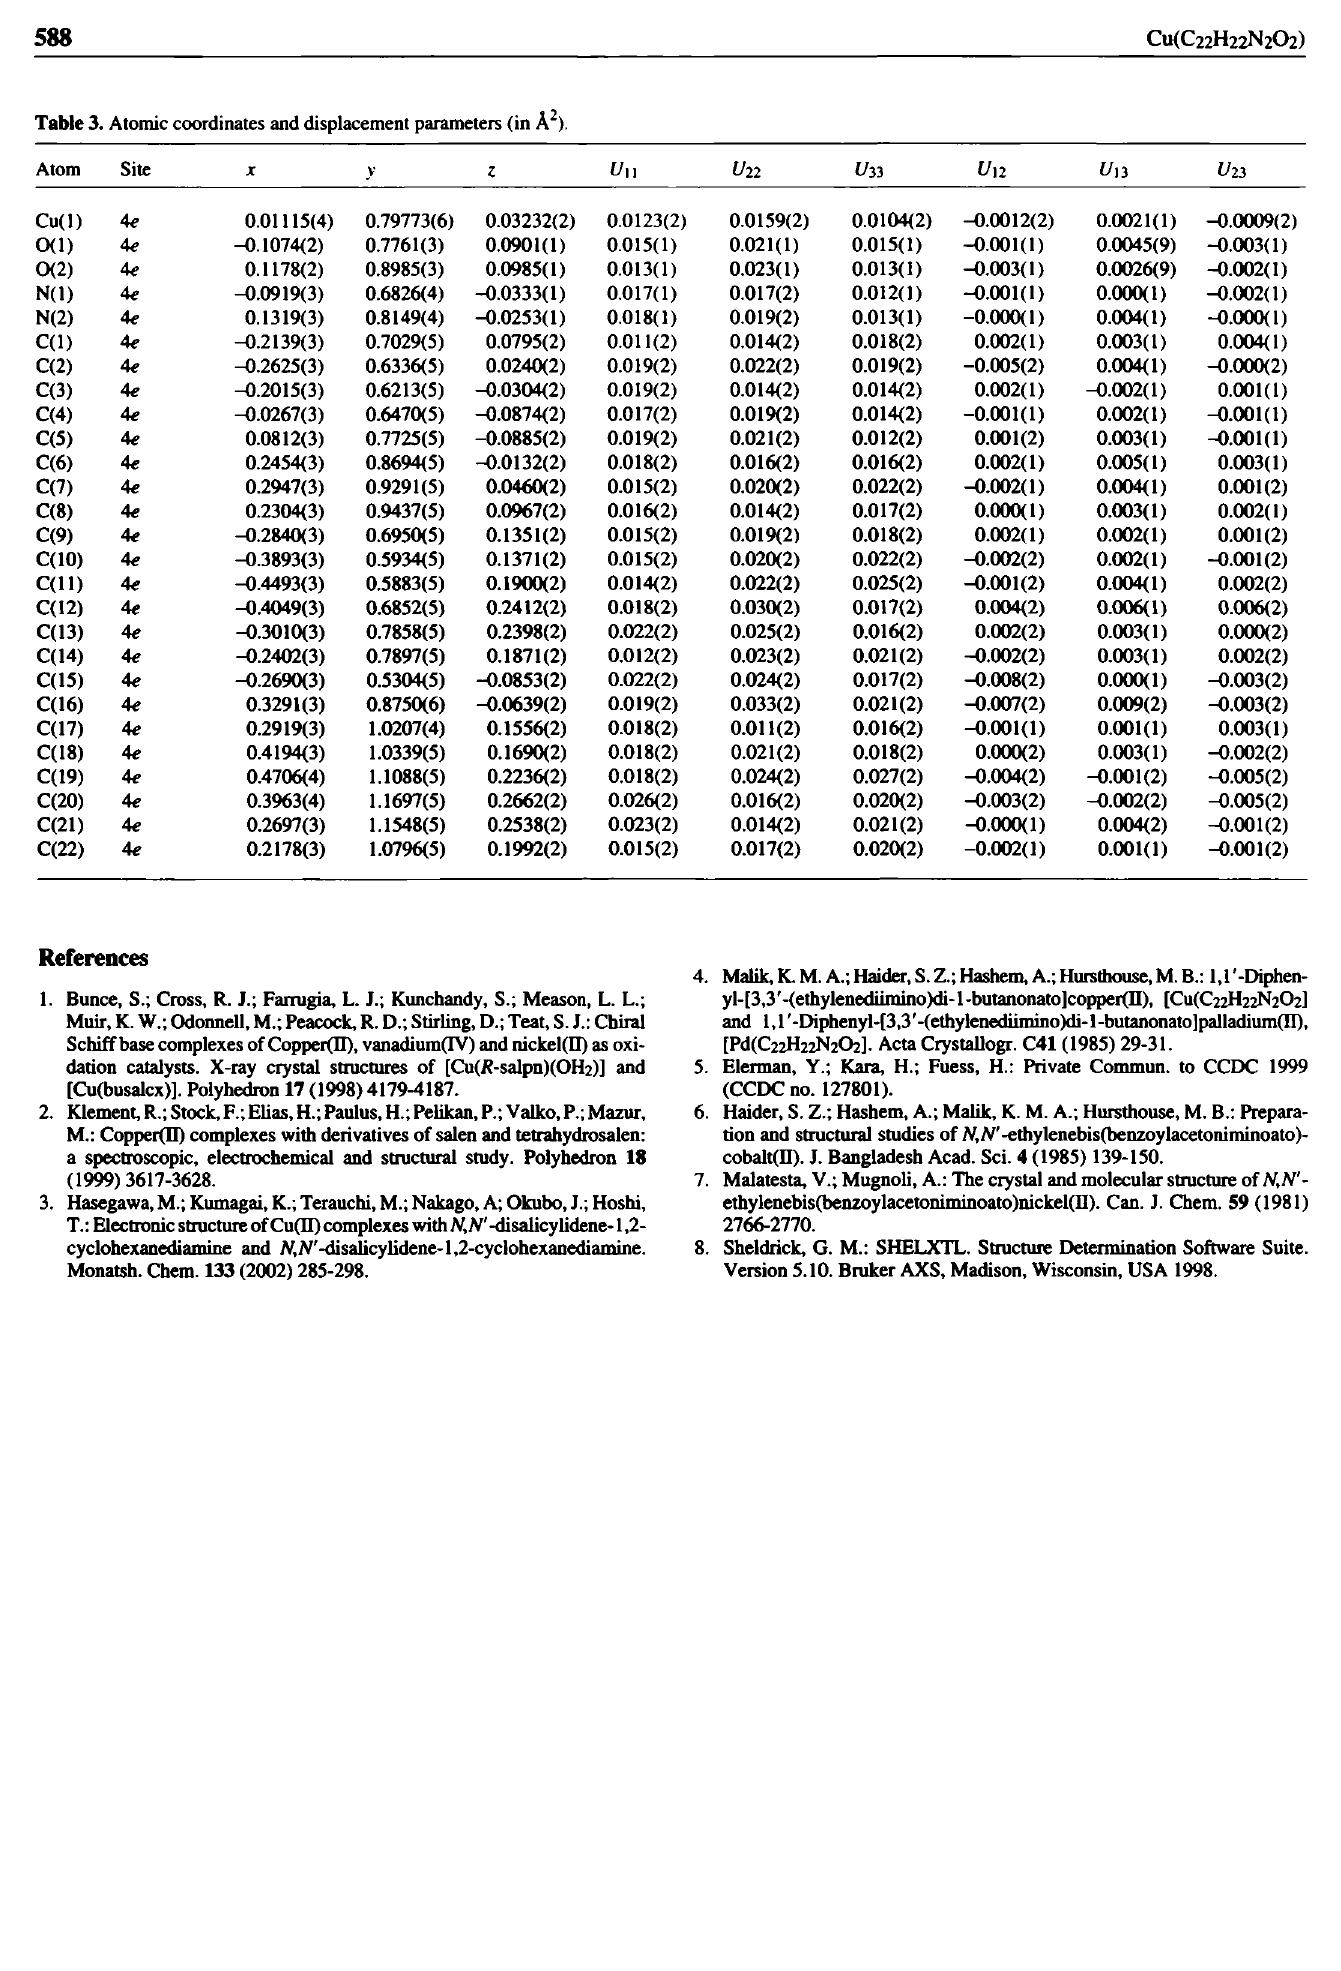
Table 3. Atomic coordinates and displacement parameters (in A 2